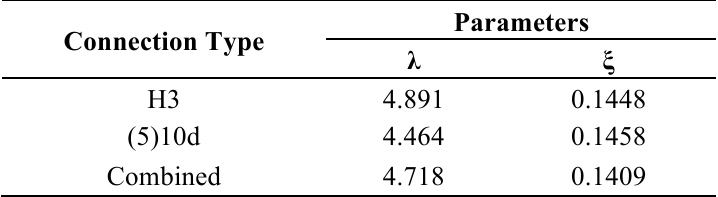
Table 6. Lognormal parameters for roof-to-wall connections.